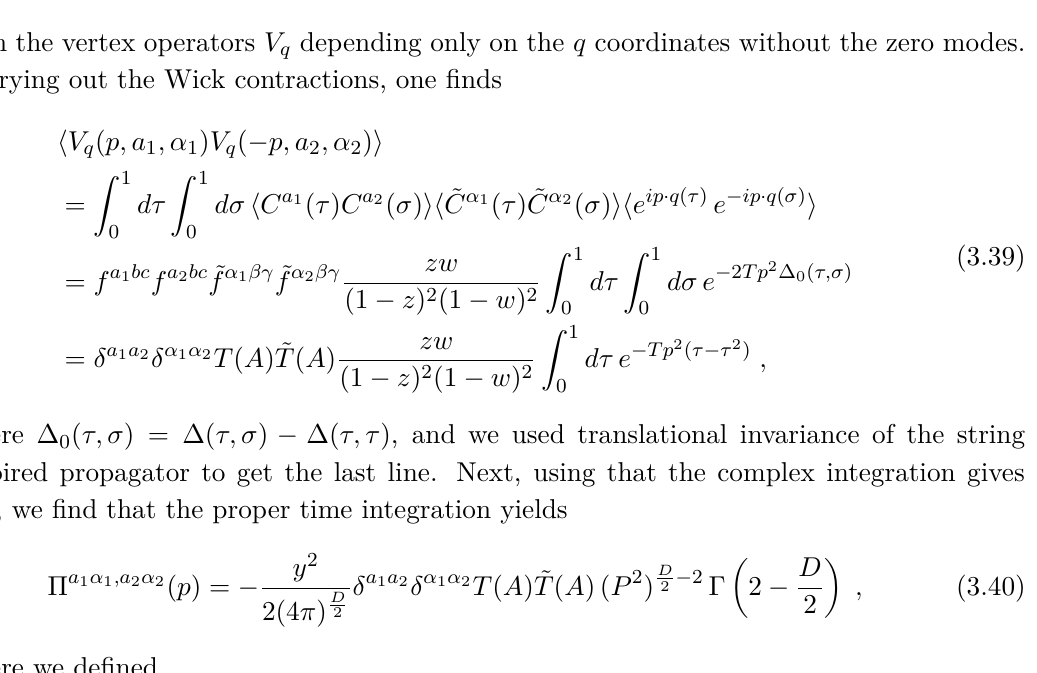
Figure 4 . Self-energy contribution to the bi-adjoint propagator at one-loop due to a virtual scalar particle. The charge of the particle in the loop is specified by occupation numbers r and ˜ r